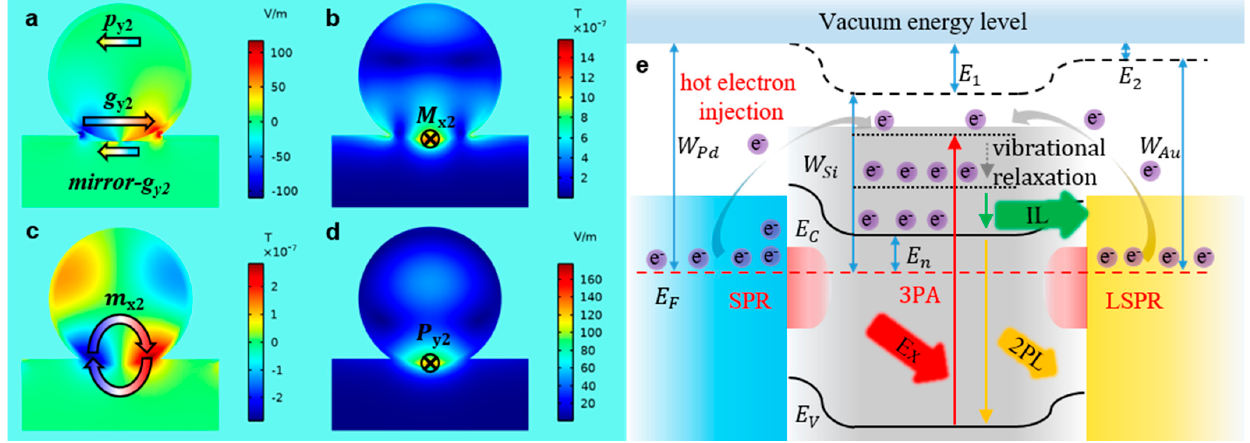
Figure 6. ( a − d ), the numerical electromagnetic field distribution of the system ‐ 2 at 775 nm: the z component of the electric field distribution of the nanocavity ( a , YZ); the total magnetic field distribution of the nanocavity ( b , YZ); the z component of the magnetic field distribution of the nanocavity ( c , XZ); the total electric field distribution of the nanocavity ( d , XZ). ( e ), the energy level of the system ‐ 2.